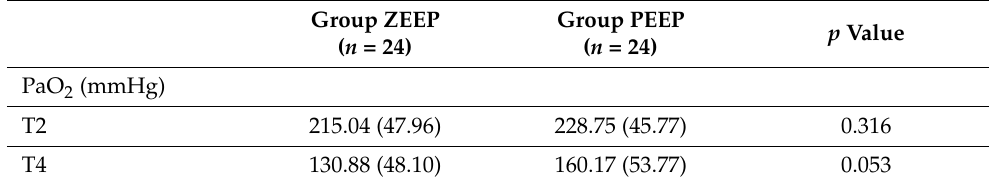
Table 2. Respiratory and hemodynamic variables in the ZEEP and PEEP groups at each time